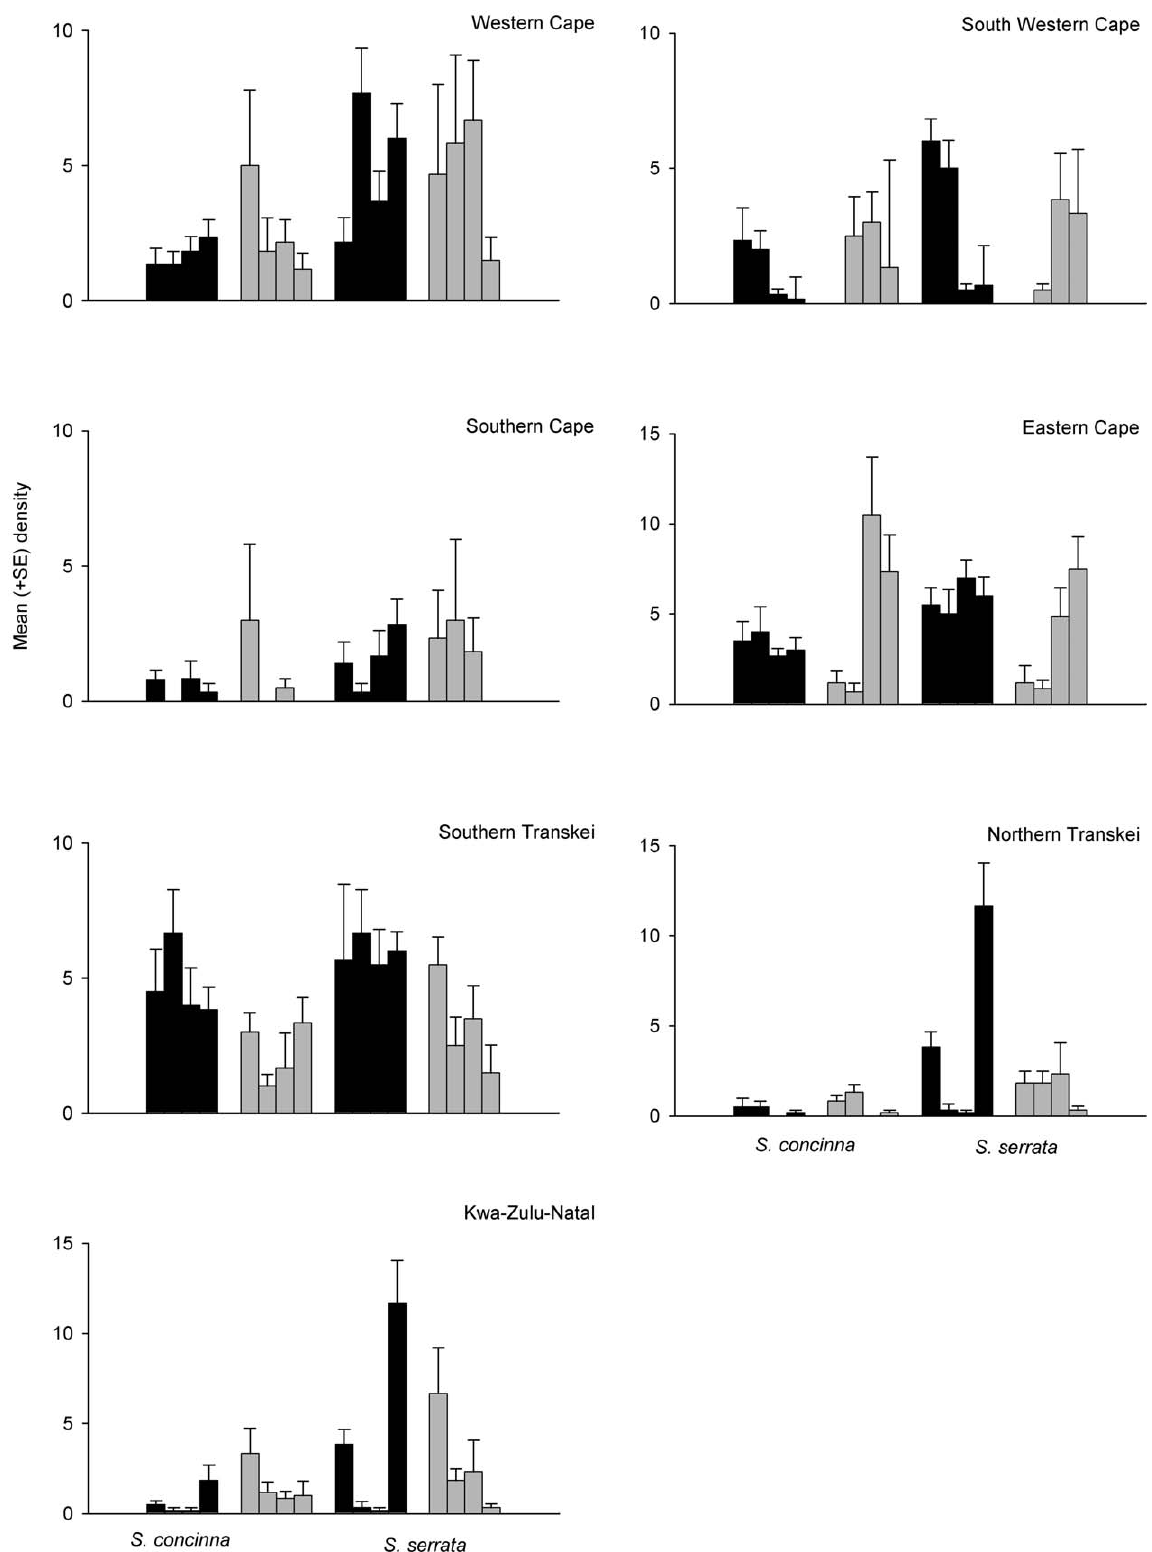
Figure 3. Mean ( + SE; n =6) density of juvenile Siphonariaconcinna and S.serrata in small (black bars) or large patches (grey bars) in 7 different regions (Western Cape, South Western Cape, Southern Cape, Eastern Cape, Southern Transkei, Northern Transkei and Kwa-Zulu Natal).